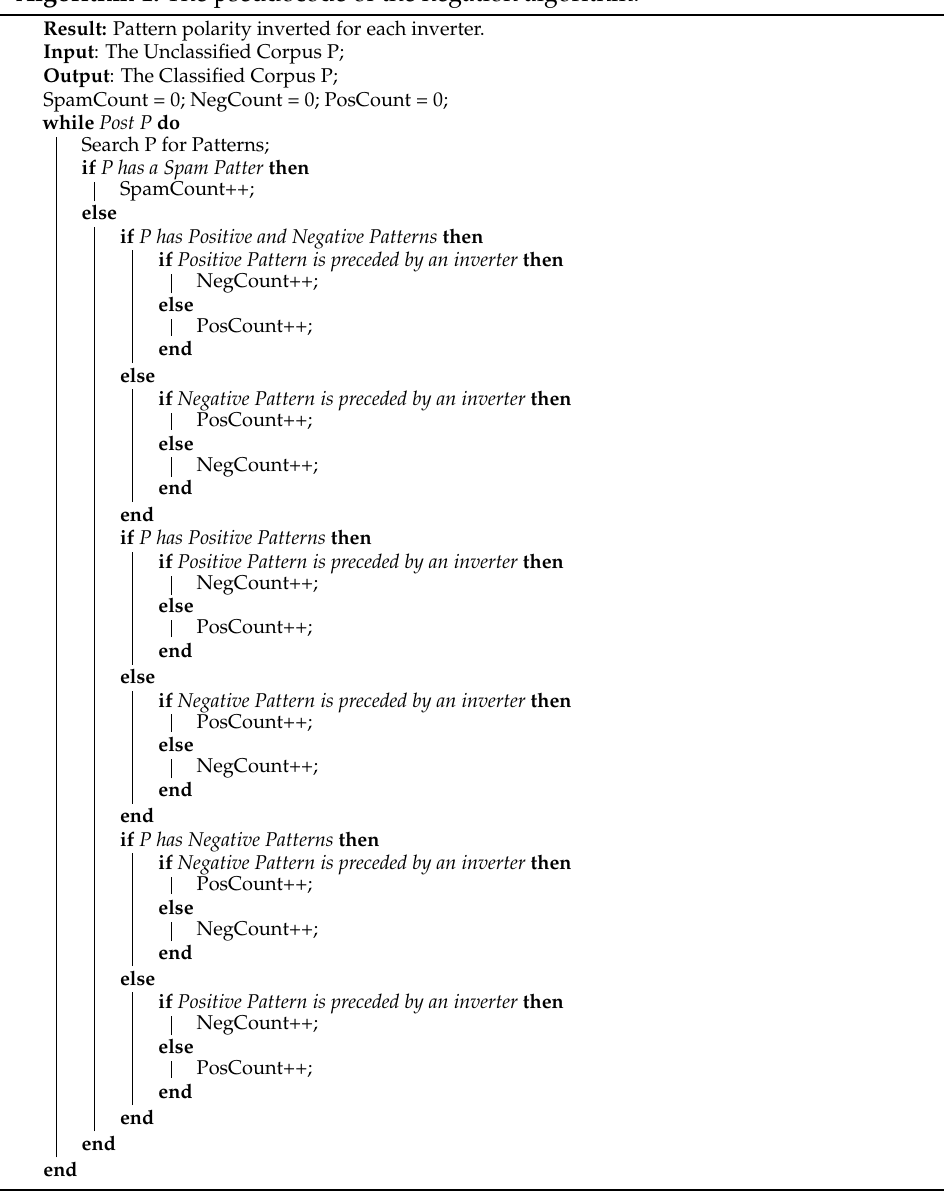
Algorithm 1: The pseudocode of the negation